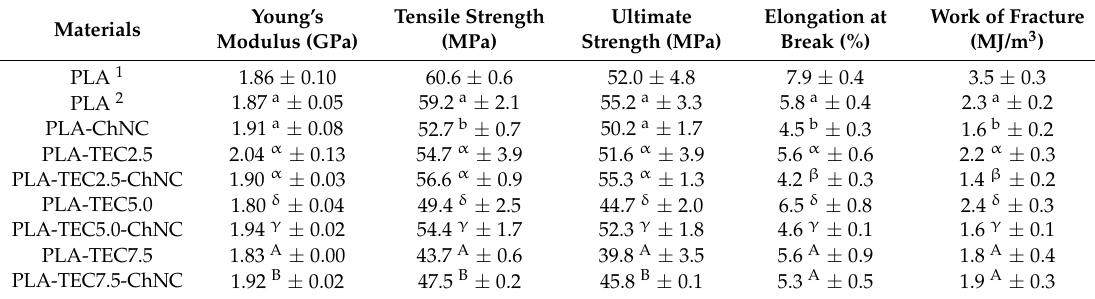
Table 3. Mechanical properties of PLA nanocomposites and their counter-part materials without chitin